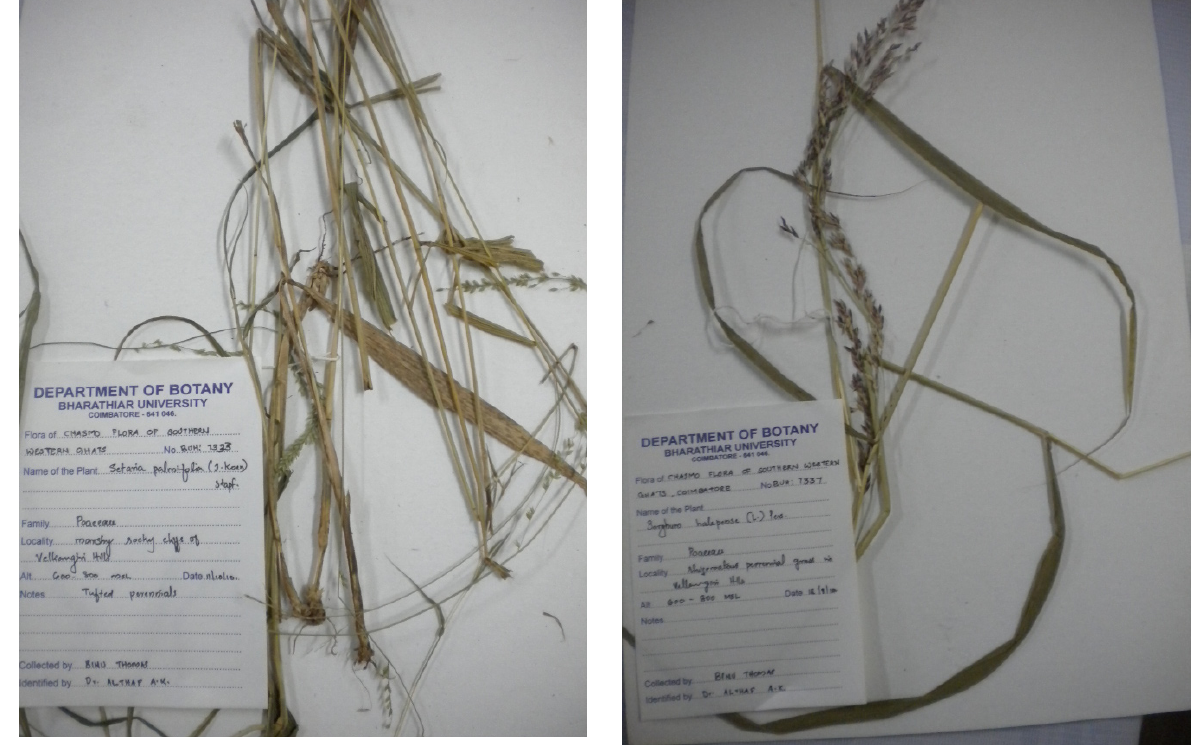
Image 30. Setaria palmifolia (J. Koenig) Stapf.